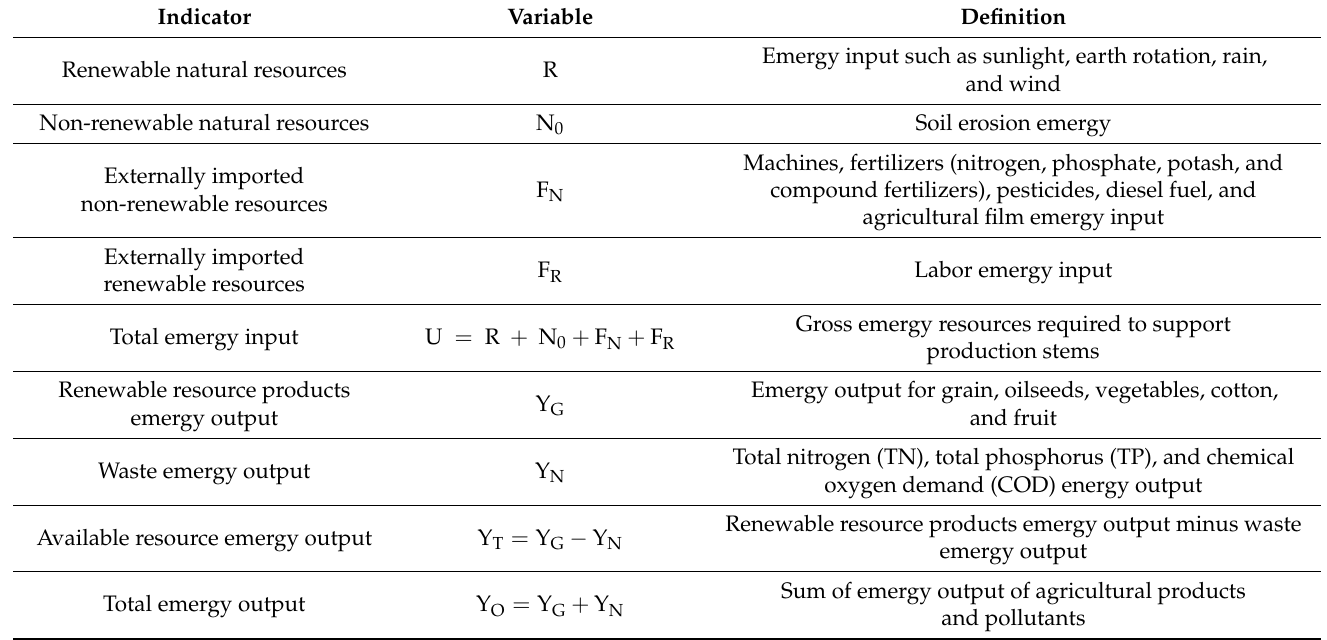
Table 1. Agroeconomic ecosystem indicator.